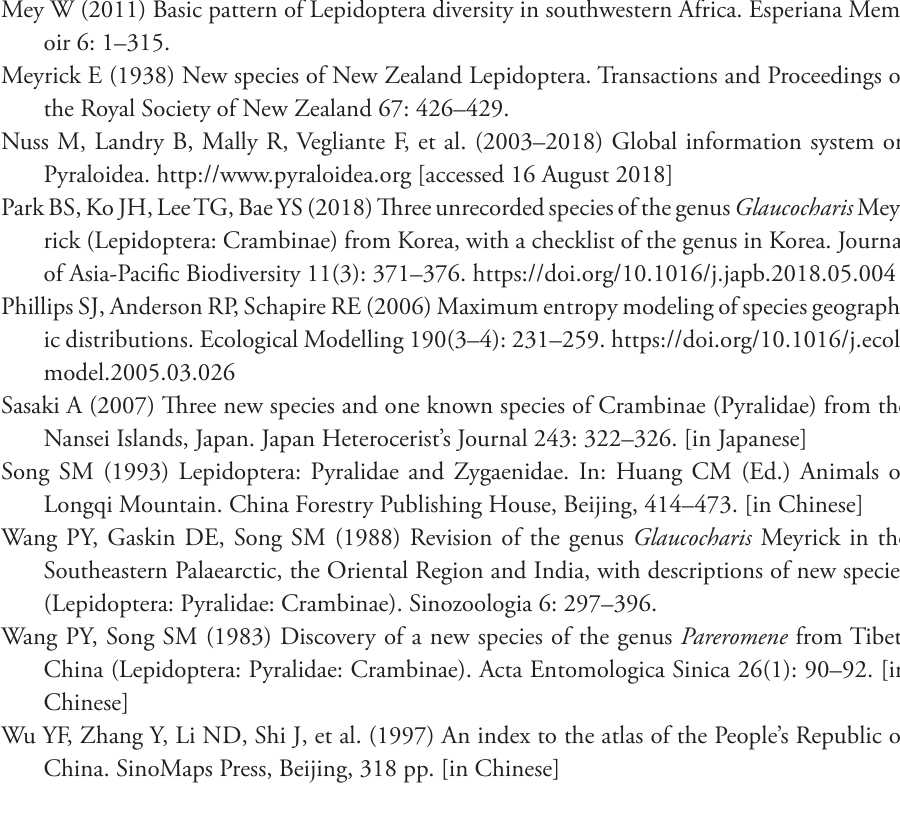
Explanation note: Table S1. Overview of Chinese localities where Glaucocharis species have been collected (administrative divisions are given in bold) with geographical coordinates in the decimal system; Table S2. Environmental variables used in the study and their contribution percentage and permutation